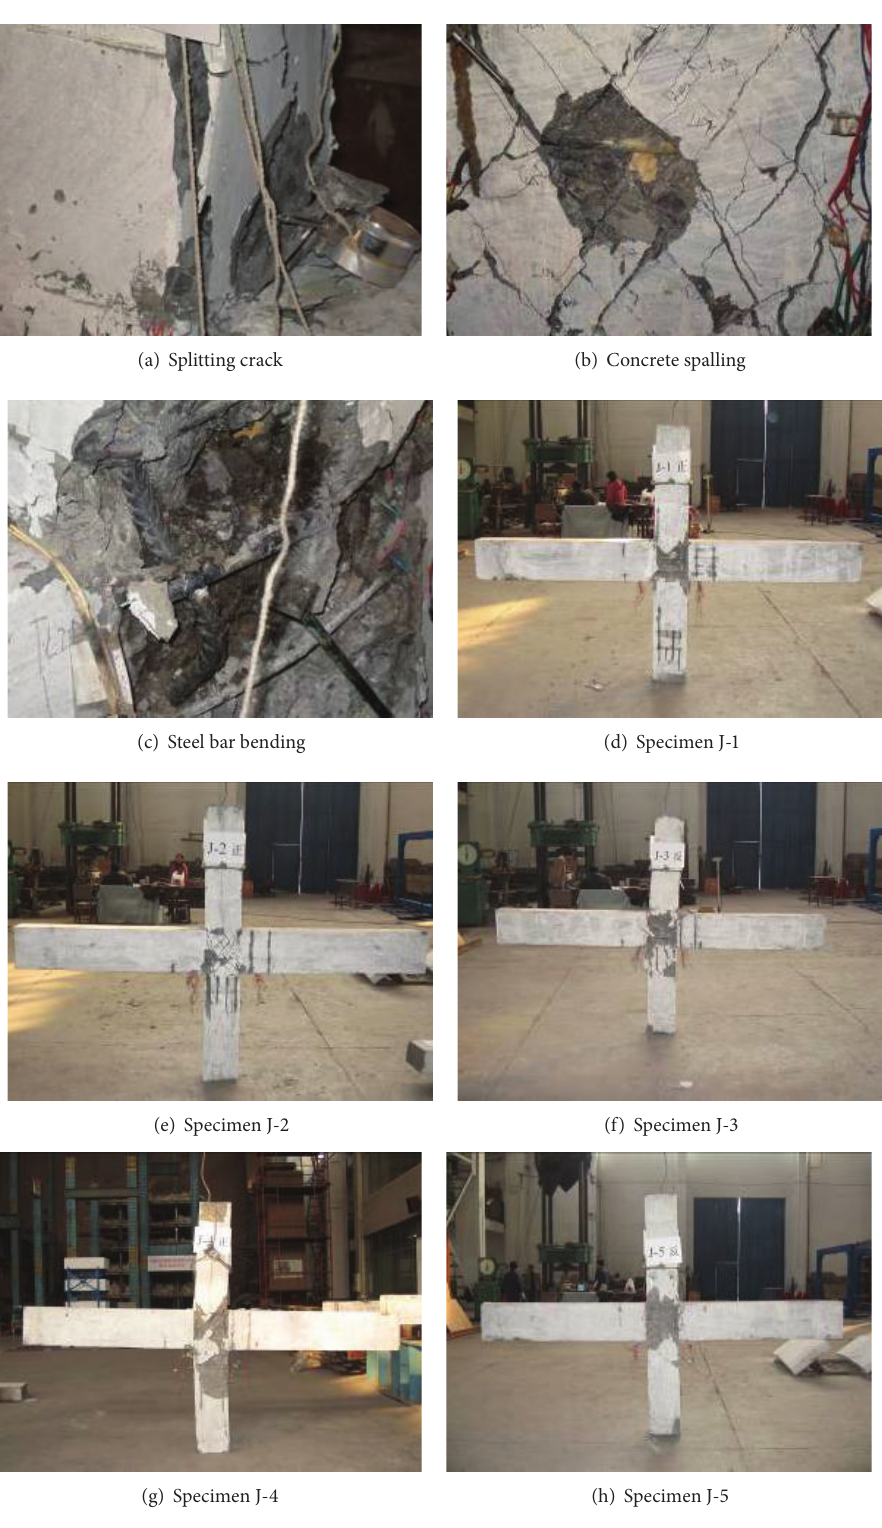
Figure 6: Experimental phenomenon in failure